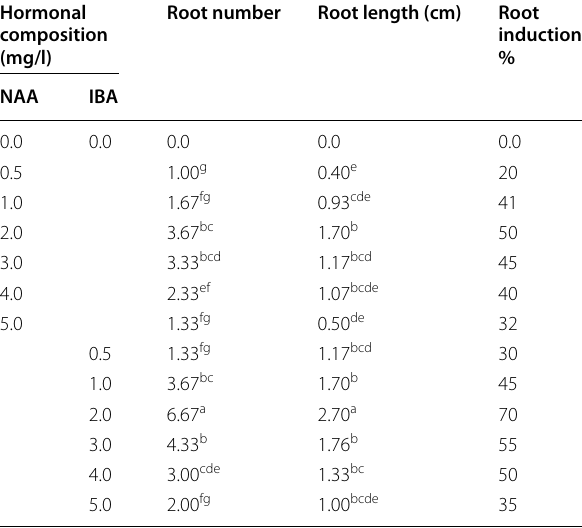
Table 2: Effect of auxins on in vitro root induction of Phoebe